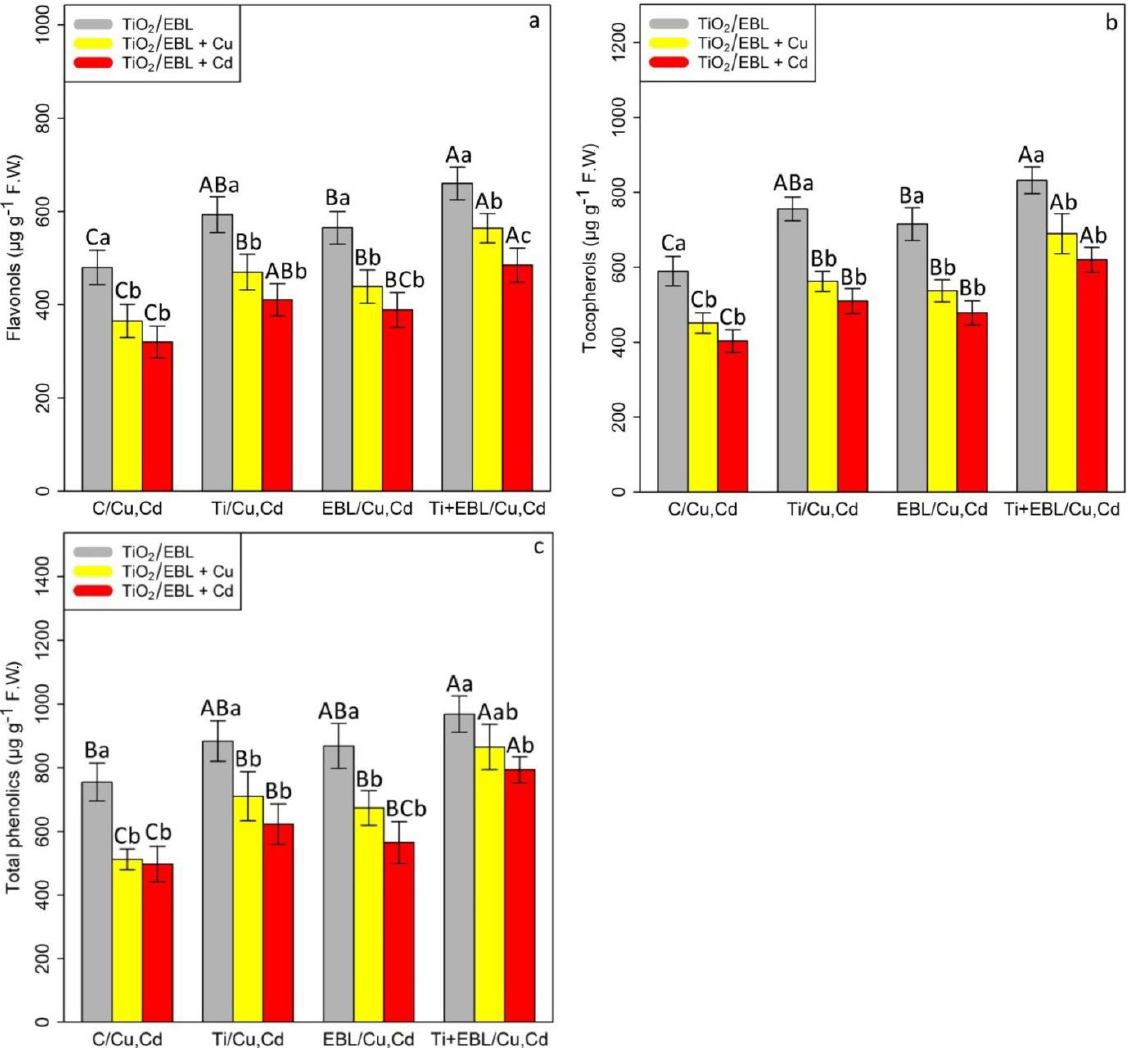
Figure 3. The impact of the co-application of 24-epibrassinolide and titanium oxide nanoparticles individually and combined on nonenzymatic antioxidant activities (( a ) flavonols, ( b ) tocopherols, ( c ) total phenolics) in bamboo species ( Pleioblastus pygmaeus ) with 100 µM Cu and 100 µM Cd. In